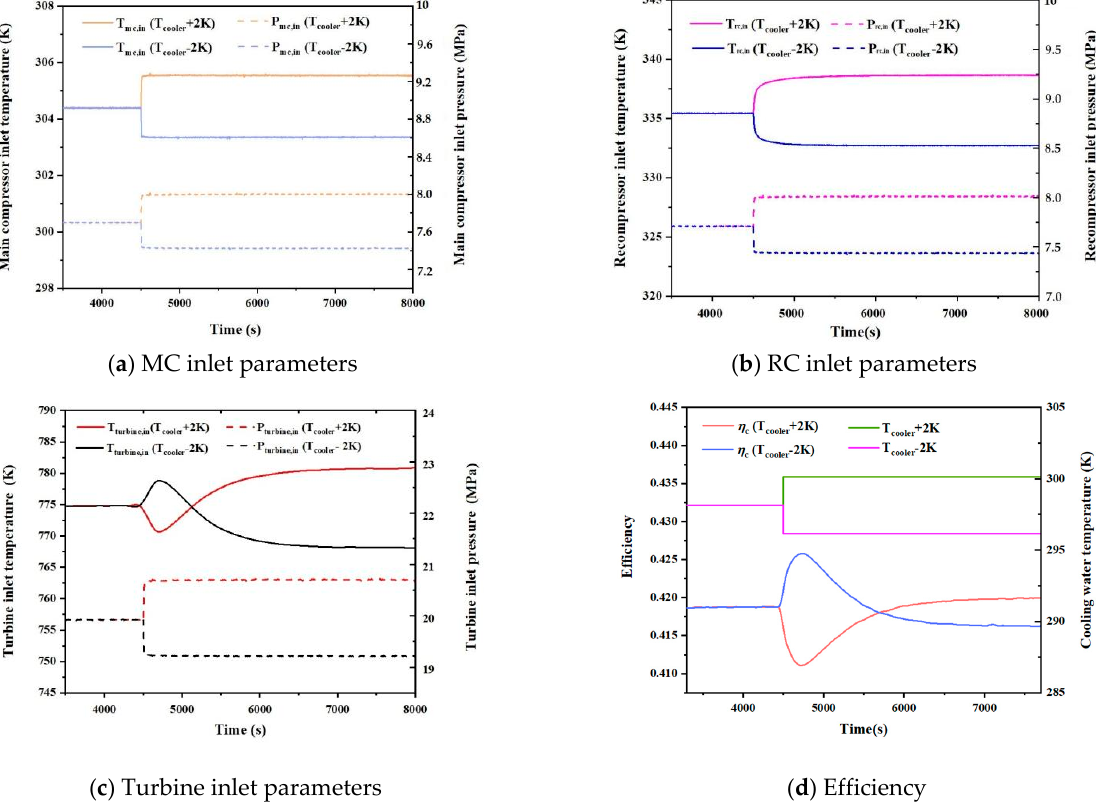
Figure 6. Response curves of main parameters with cooling water temperature disturbance.